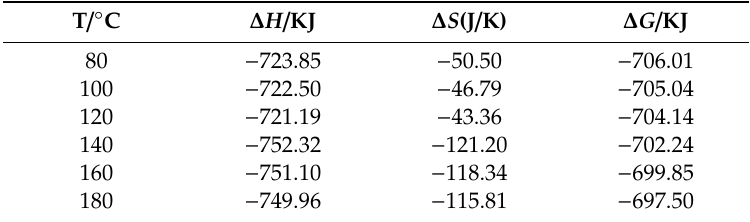
Table 2. Thermodynamic parameters of Equation (1) at di ff erent